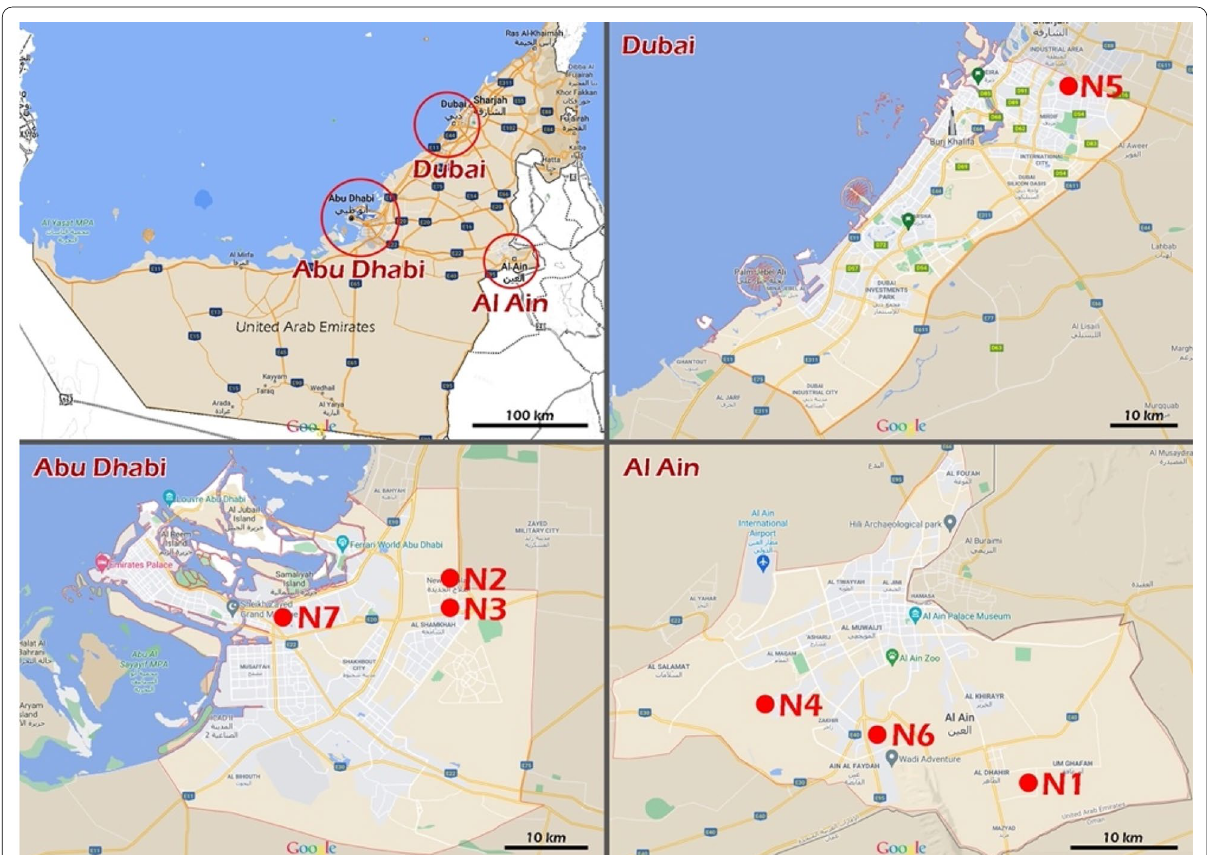
Fig. 4 The geographical locations of the case studies neighborhoods in Al Ain, Abu Dhabi and Dubai Cities,